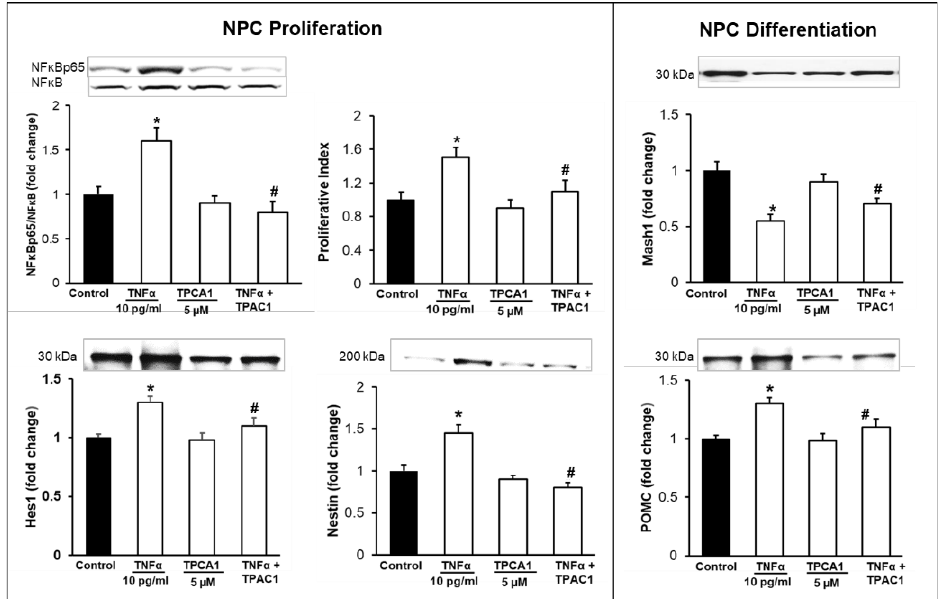
Figure 7. Effects of NFĸB Inhibitor (TPCA1) on NPC Proliferation/Differentiation. Hypothalamic NPCs were treated with TNFα (10 pg/mL), TPCA1 (5 μM) and TNFα + inhibitor in complete or differentiation medium for 24 h. Values are (Mean ± SEM of n = 4 independent experiments with each treatment performed in duplicate) normalized to untreated control cells and expressed as fold change. * p < 0.05 vs. untreated cells; # p < 0.05 TNFα + TPAC1 vs. TNFα .